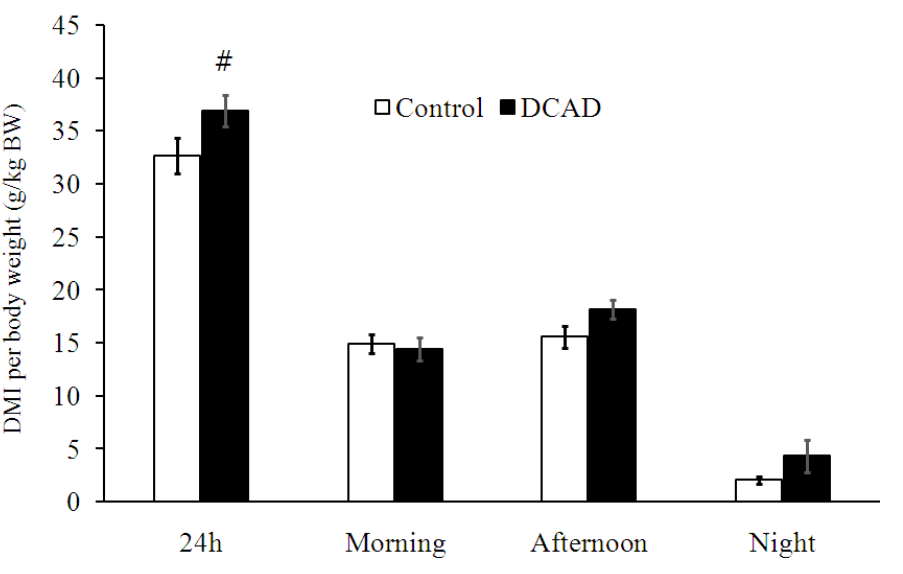
Figure 1. Effects of dietary cation and anion difference (DCAD) on the averaged 24-h dry matter intake per body weight (DMI/BW), morning DMI/BW from 0700 h to 1300 h, afternoon DMI/BW from 1300 to 1900 h, night-time DMI/BW from 1900 to 0700 h. The DCAD levels of the DCAD-23 and DCAD-39 groups were 22.8 and 39.1 mEq/100 g DM, respectively. Pound sign indicates the tendency of difference, # 0.05<p<0.1.